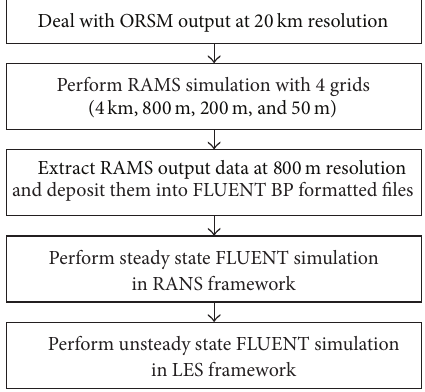
Figure 1: Flowchart of the